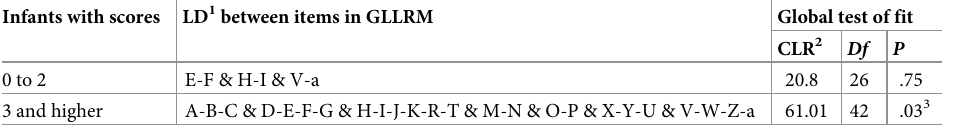
Table 4. Global tests of fit in graphical loglinear Rasch models for the two groups of infants defined by scores 0 to 2 and 3 and higher on the total CIMHQ. Infants with scores LD 1 between items in GLLRM